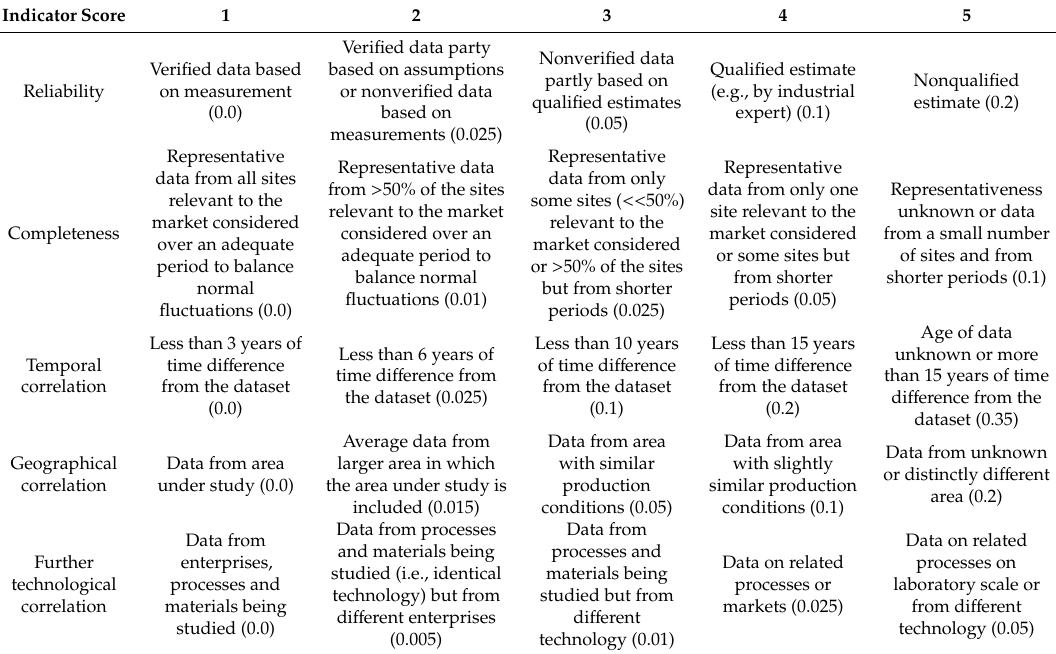
Table 9. Data quality indicators (DQI) and uncertainty.